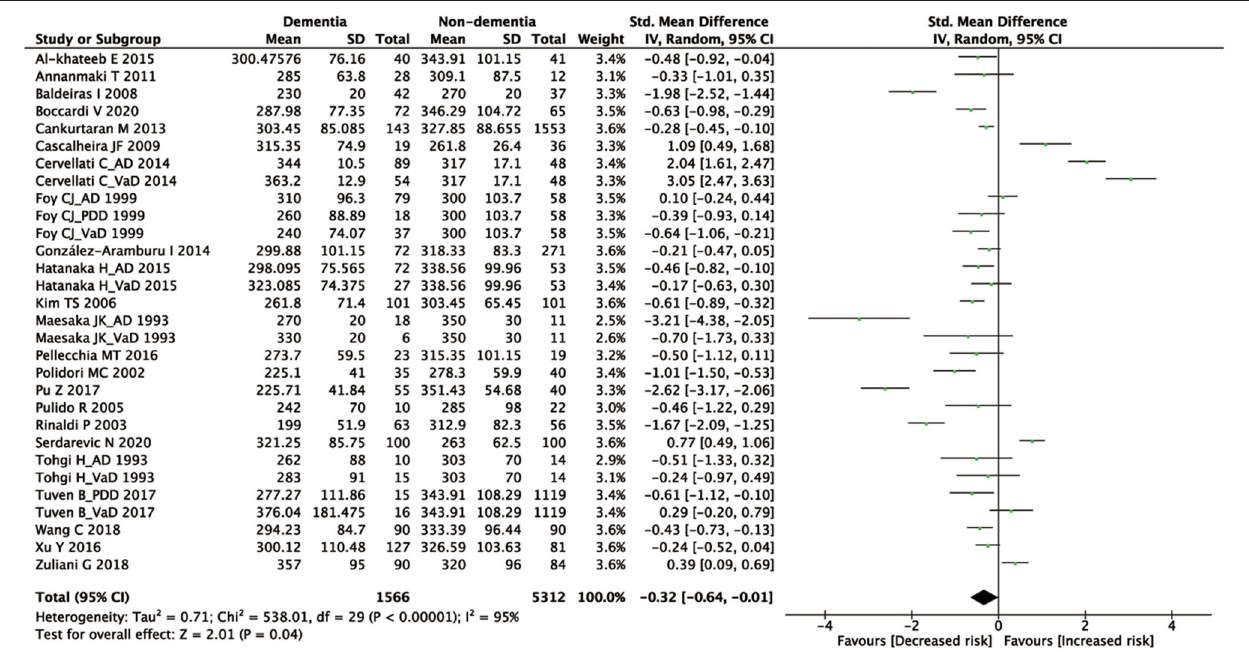
FIGURE 2 | A forest plot of the SMD in the levels of UA between dementia and non-dementia. CI, confidence interval; SMD, standard mean difference; UA, uric